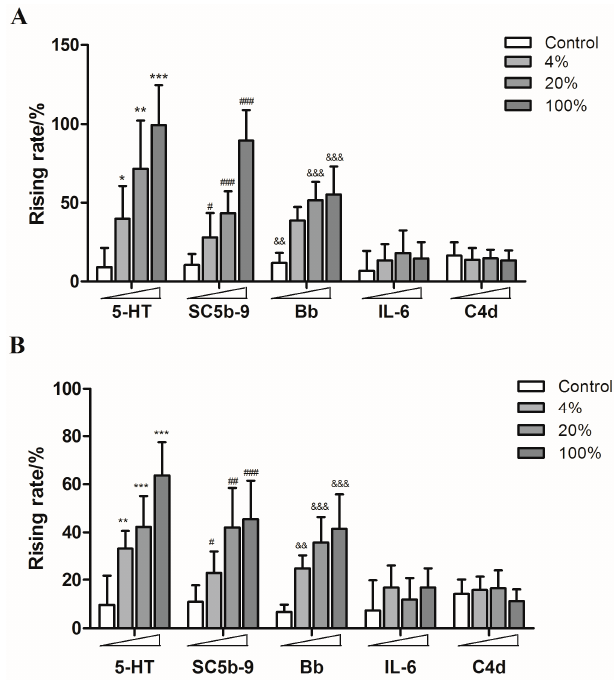
Figure 5. The rising rates of 5-HT, SC5b-9, Bb, IL-6, and C4d in animals ′ plasmas after treating with different doses of SHL injection and YXC injection (( A ): SHL injection; ( B ): YXC injection). * p < 0.05, ** p < 0.01, *** p < 0.001 vs. control; # p < 0.05, ## p < 0.01, ### p < 0.001 vs. control; && p < 0.01, &&& p < 0.001 vs. control ( n = 10).